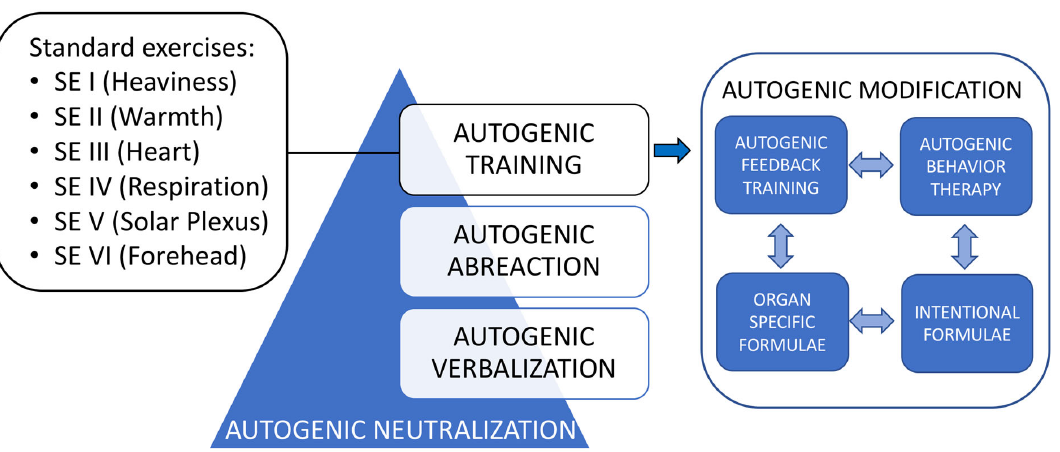
Figure 1. Autogenic training: combinations and procedural interaction. Adapted from Luthe 1979 [5]. SE: standard exercises.